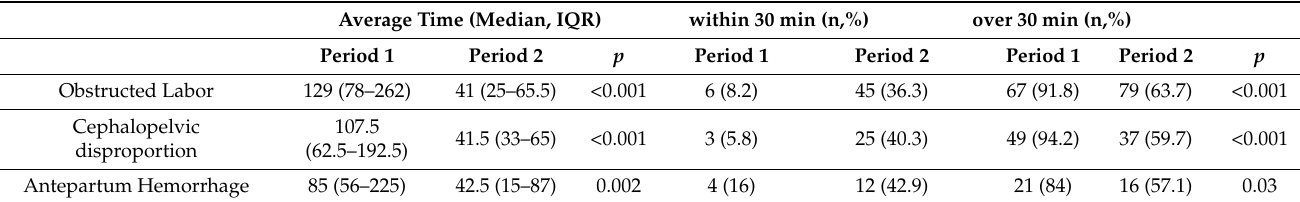
Table 2. Incision to decision time interval by indications of emergency cesarean